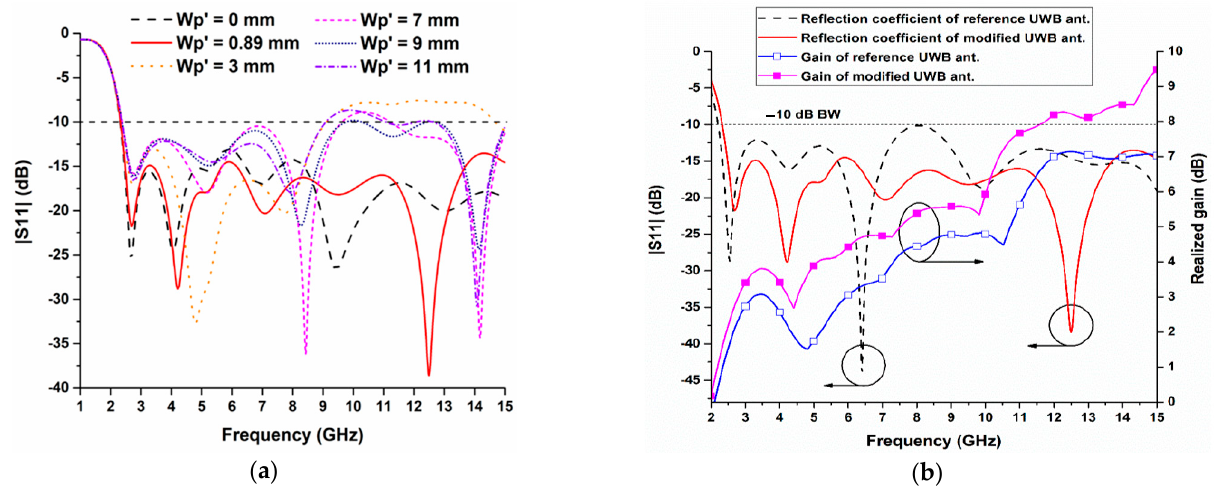
Figure 3. Single element UWB antenna; ( a ) Study of patch dimension change of UWB antenna on the reflection coefficient and bandwidth; ( b ) Reflection coefficient and realized gain comparison of reference and modified UWB antenna.